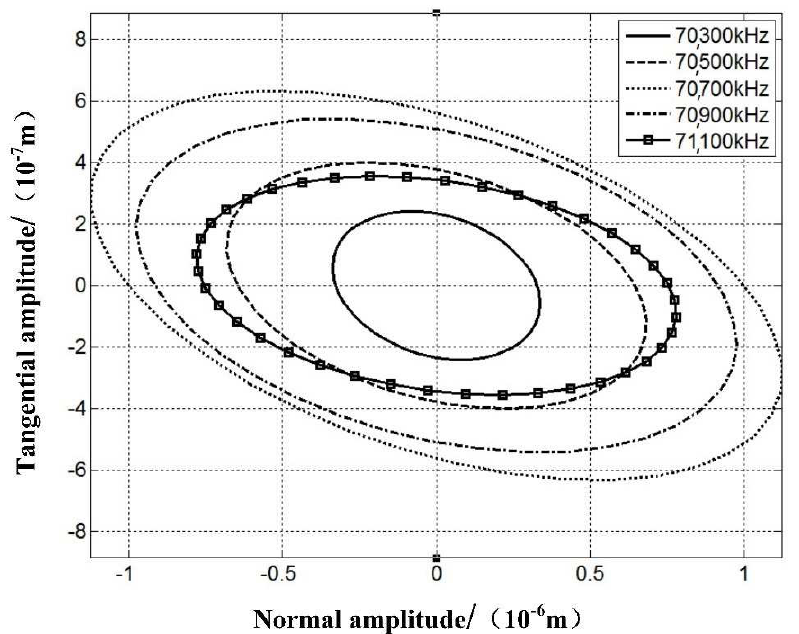
Figure 11. Feet trajectory driven by harmonic response.